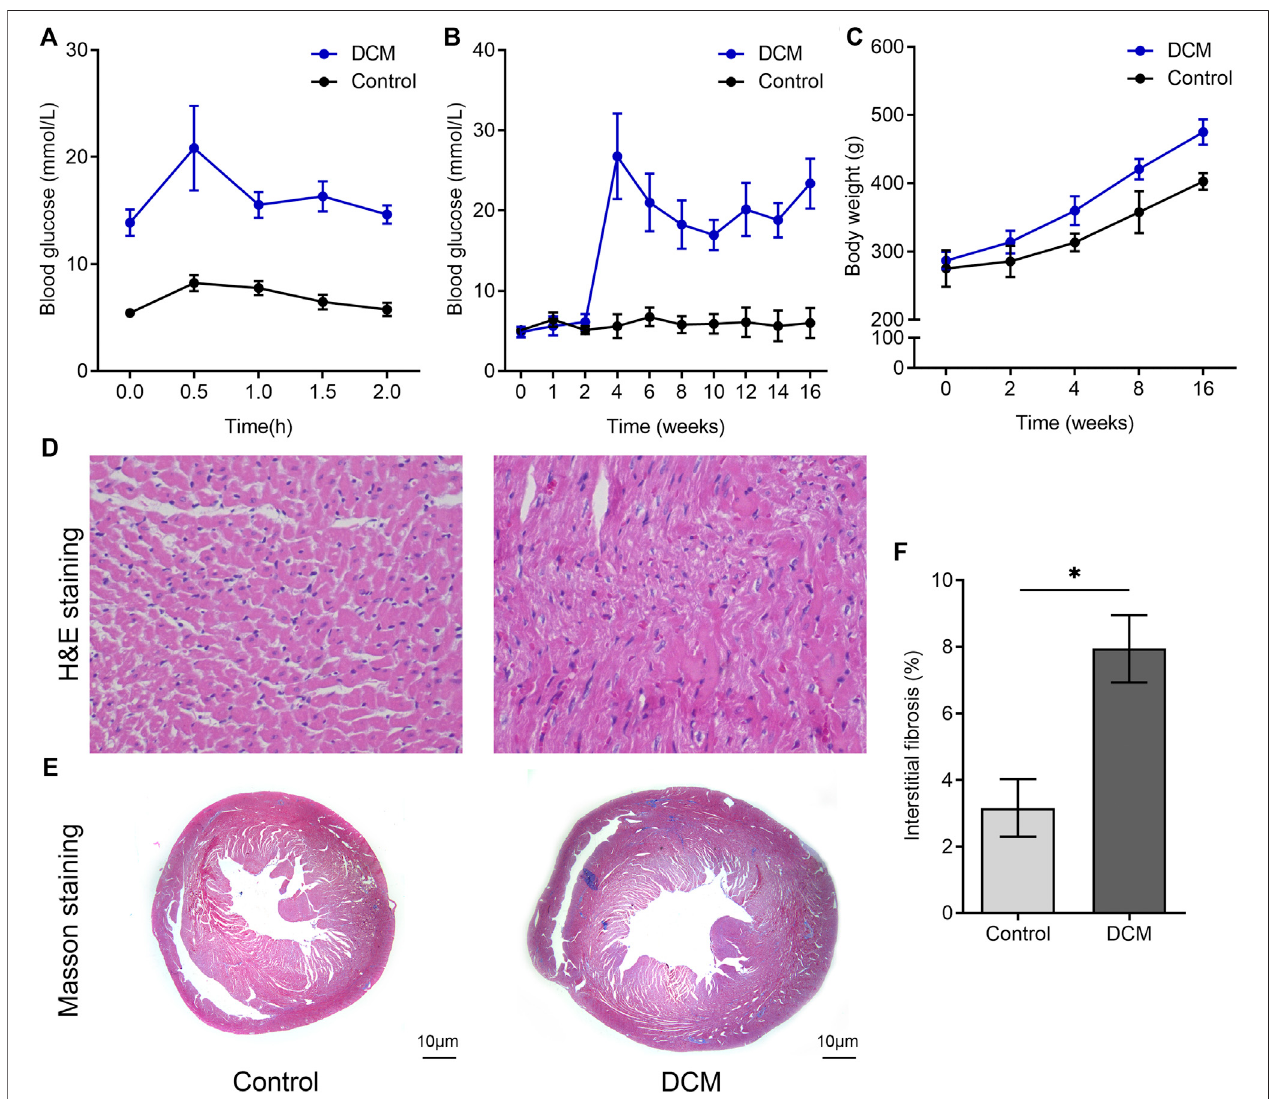
FIGURE 1 | Changes of blood glucose level and histopathology in DCM rats. SD rats were fed a high-fat diet (HFD) for 4 weeks before streptozotocin (STZ) was injectedintraperitoneally atadoseof60 mg/kg, andratswerefedforanother12 weeks. (A) Intraperitonealglucose tolerancetests (IPGTTs)wereusedtoidentifyinsulin resistance in the two groups. (B) The FBG levels of the two groups measured at indicated times. (C) The body weight of the two groups was monitored at the indicated time.The paraf fi n sections of ratleft ventricular tissues after (D) hematoxylinand eosin(H&E) staining and (E) Masson ’ strichrome staining. (F) Quantitative analysis of interstitial Masson ’ s trichrome staining ( n (cid:2) 6 per group).